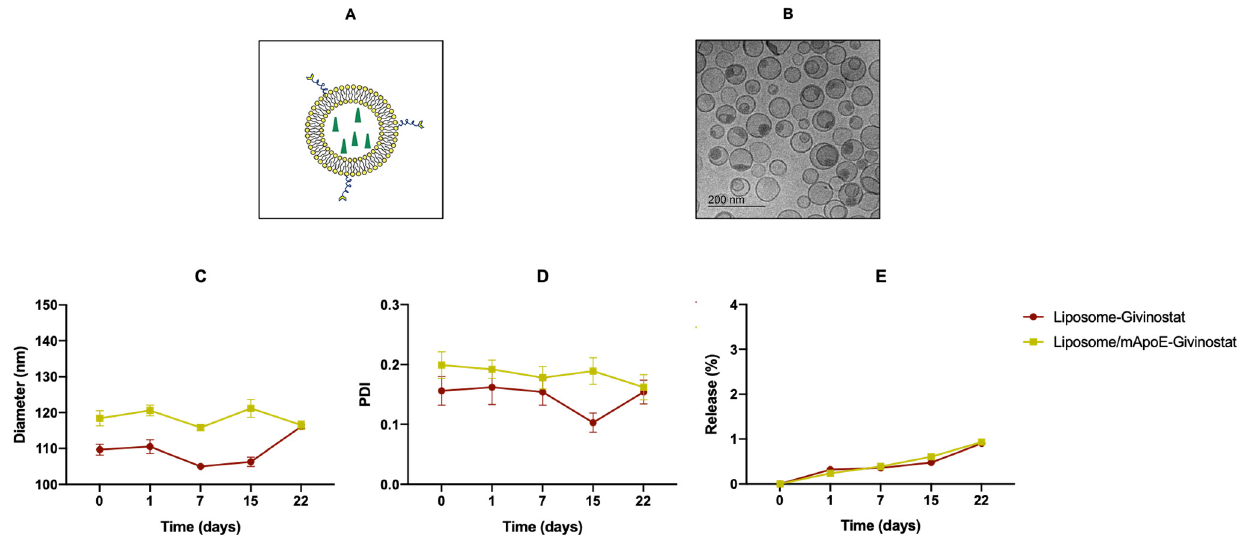
Figure 1. ( A ) Representative drawing showing a liposome loaded with Givinostat (green triangle) and functionalized with mApoE. ( B ) Cryo-EM image of drug-loaded vesicles with diameters ranging from 30 to 100 nm. Black dots on top and inside the vesicles indicate a high drug loading efficiency. ( C – E ) The diameter, polydispersity index, and drug release of LIP-GIV and LIP/m-GIV were measured around a period of three weeks. Data are presented as the mean of at least three independent experiments ± SD. Table 1. Physico-chemical characterization of LIP-GIV and LIP/m-GIV formulations at T0. Liposomal formulation